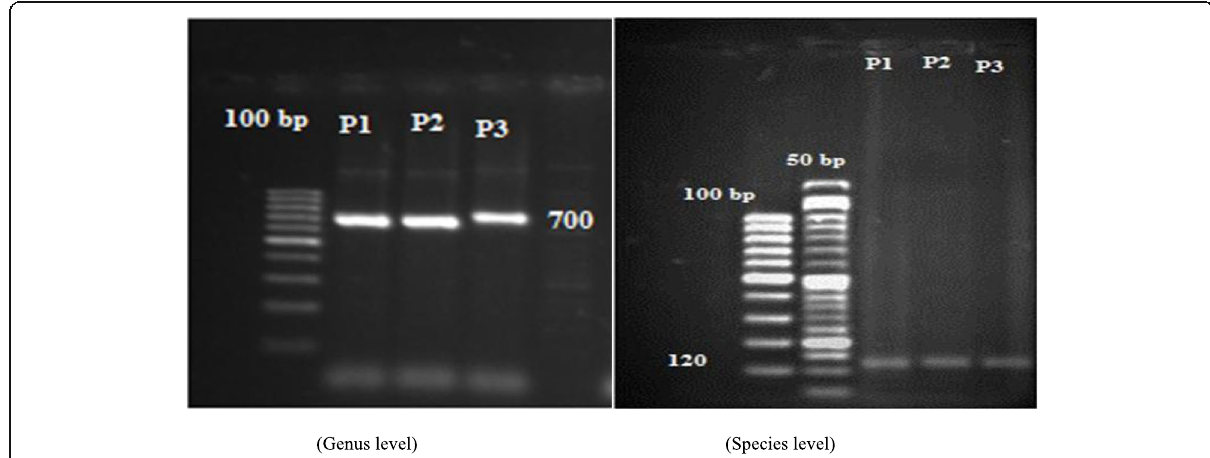
Fig. 1 DNA profile generated by Phytophthora genus and species by using specific primers, M= 100 bp and 50